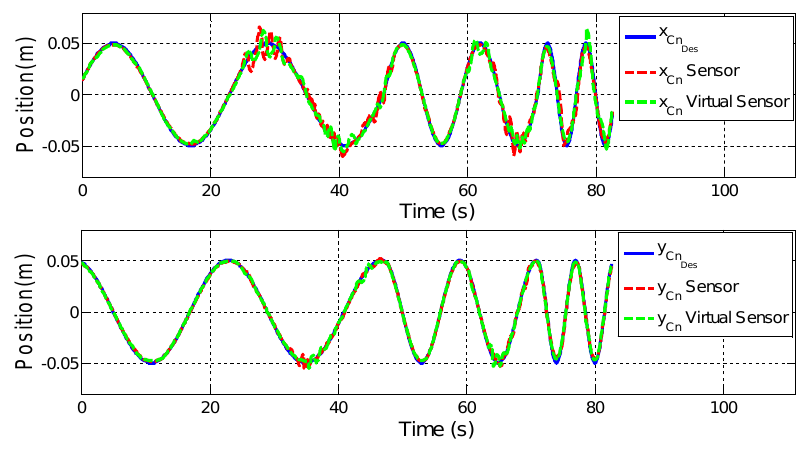
Figure 8. Validation of the Motion Virtual Sensor in WRIST operating